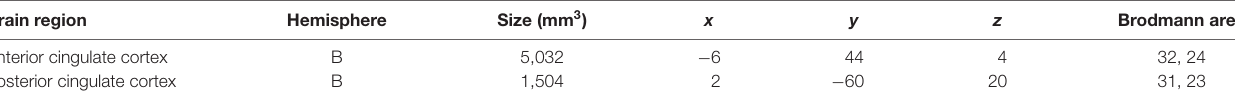
TABLE 2 | Results from semantic autobiographical memory (SAM) meta-analysis. Brain region